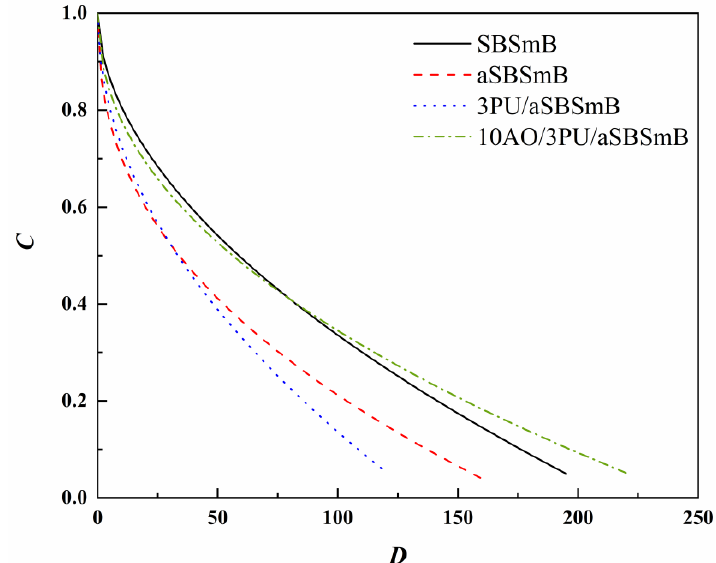
Figure 5. C - D curves of the virgin, aged, and rejuvenated SBSmB.